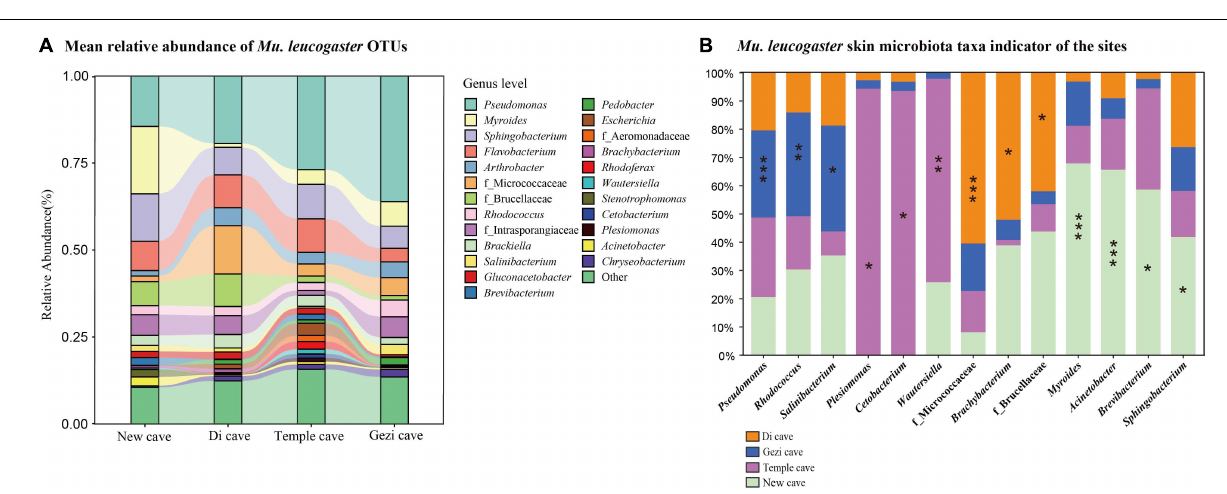
species shared the majority of OTUs. This suggested a